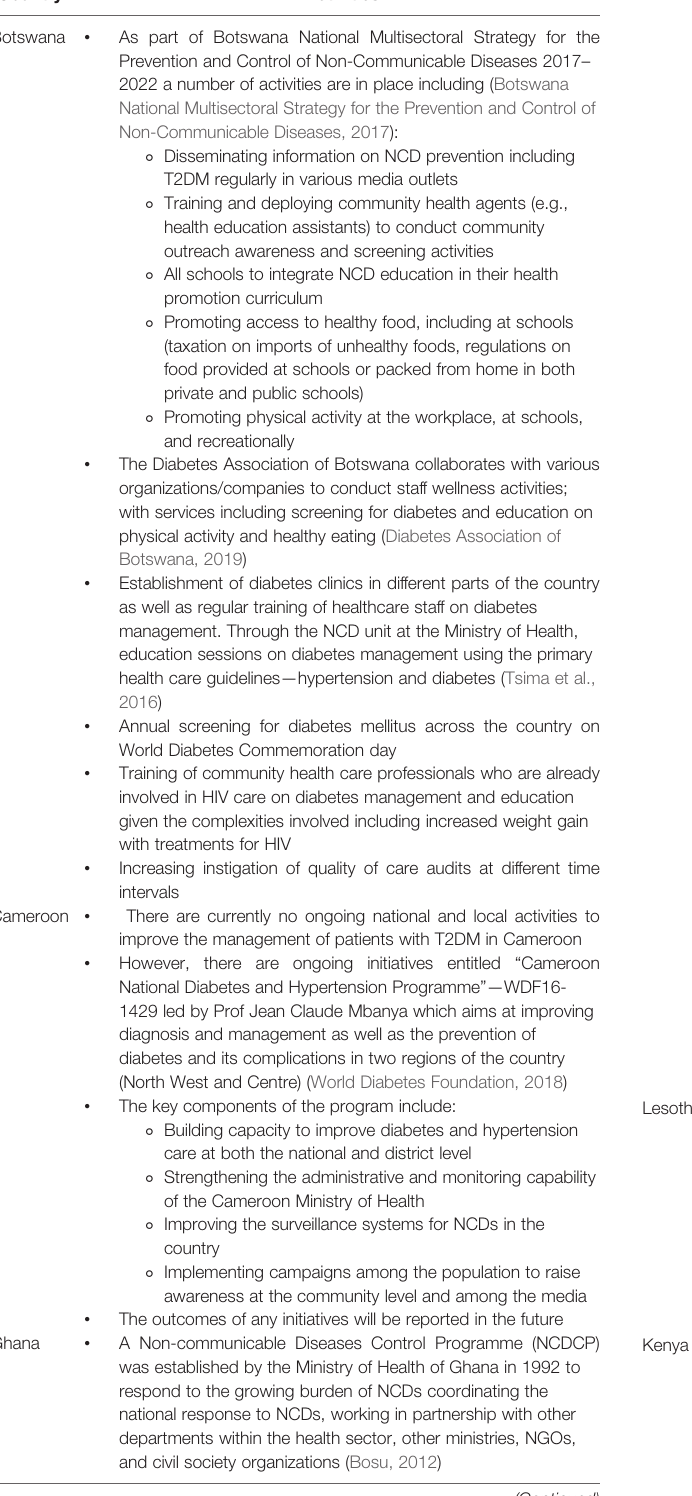
TABLE 1 | Synopsis of ongoing national and local activities to improve the management of patients with T2DM in sub-Saharan Africa. Country